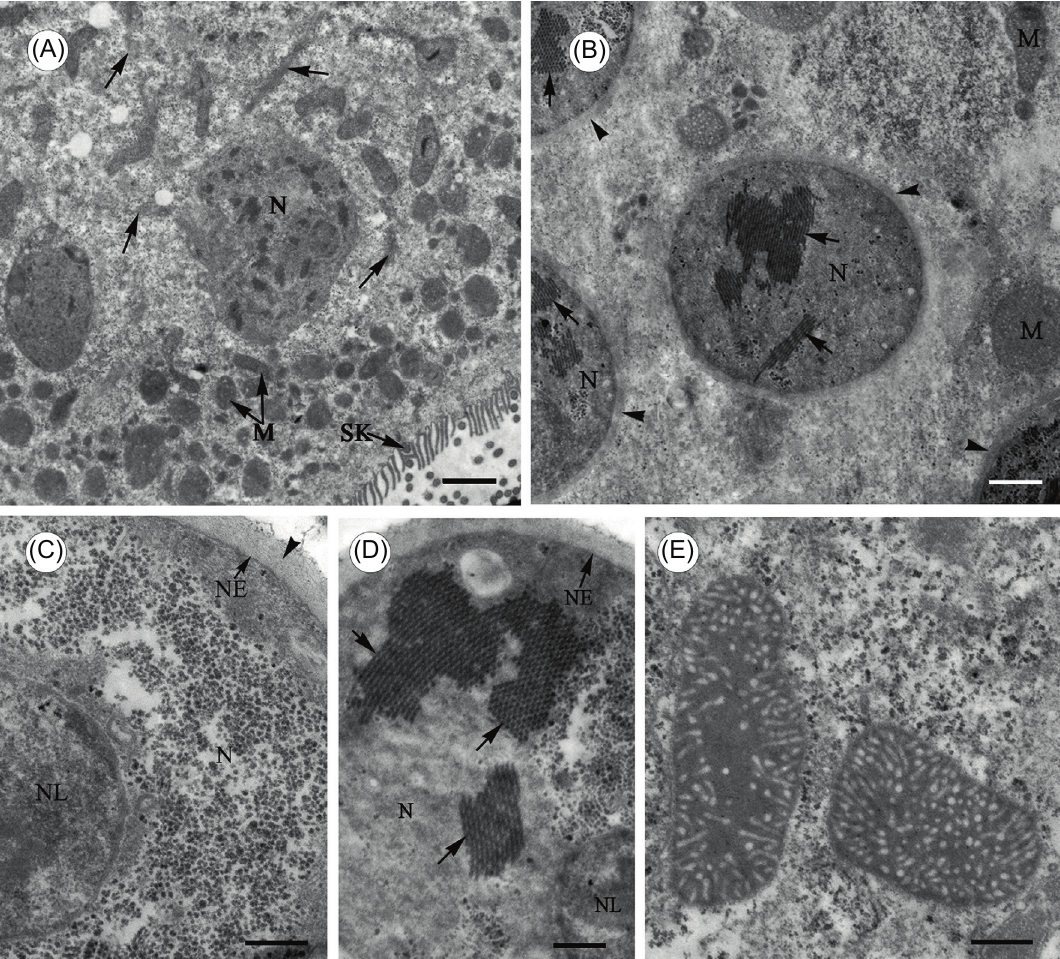
Figure 4. Transmission electron microscope images of Cepedea longa , to show fine structures of the nuclei and mitochondria within the endoplasm. (A) Cross section observed at low magnification, to show numerous thin bundles of microfilaments (arrow) dispersed in the endoplasm between nuclei (N) and mitochondria (M). SK = somatic kinetosomes. Scale bar = 20 l m. (B)–(D) Cross section of the nuclei (N), to show the nuclear envelope (NE) covered by a thick layer of microfibrils (arrowhead) and some unknown microtubular structures (arrow) in the nucleoplasm. NL = nucleolus. Scale bar in B = 10 l m, in C and D = 5 l m. (E) Thin section shows mitochondria having tubular cristae at periphery with an amorphic appearance. Scale bar = 5 l